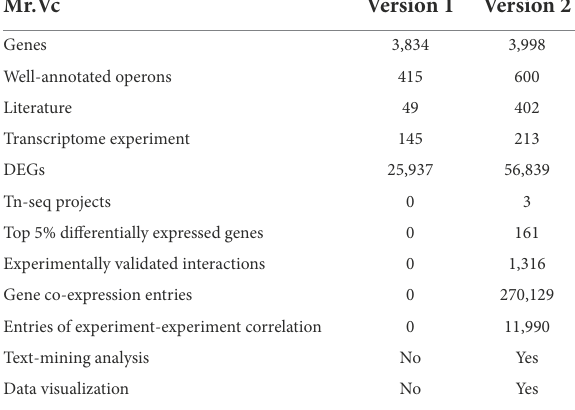
TABLE 1 Data summary in Mr.Vc v2 database.